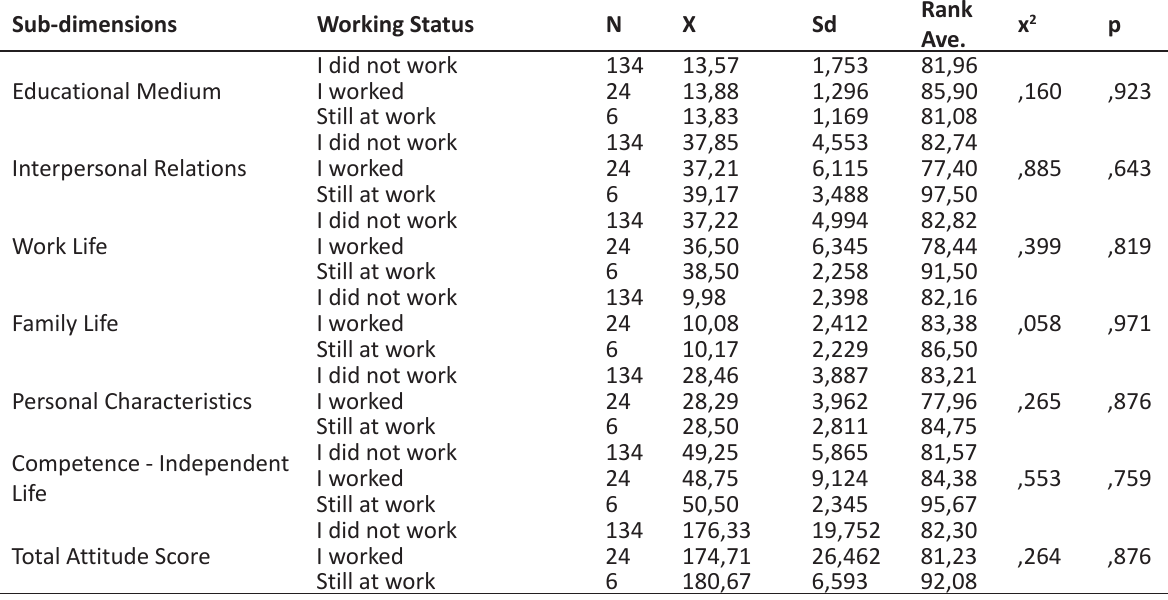
Table 8. Comparison of the Attitudes of the Participants towards the Handicapped according to the Working Status in a School that Provides Education on Special Education (the Handicapped) Sub-dimensions